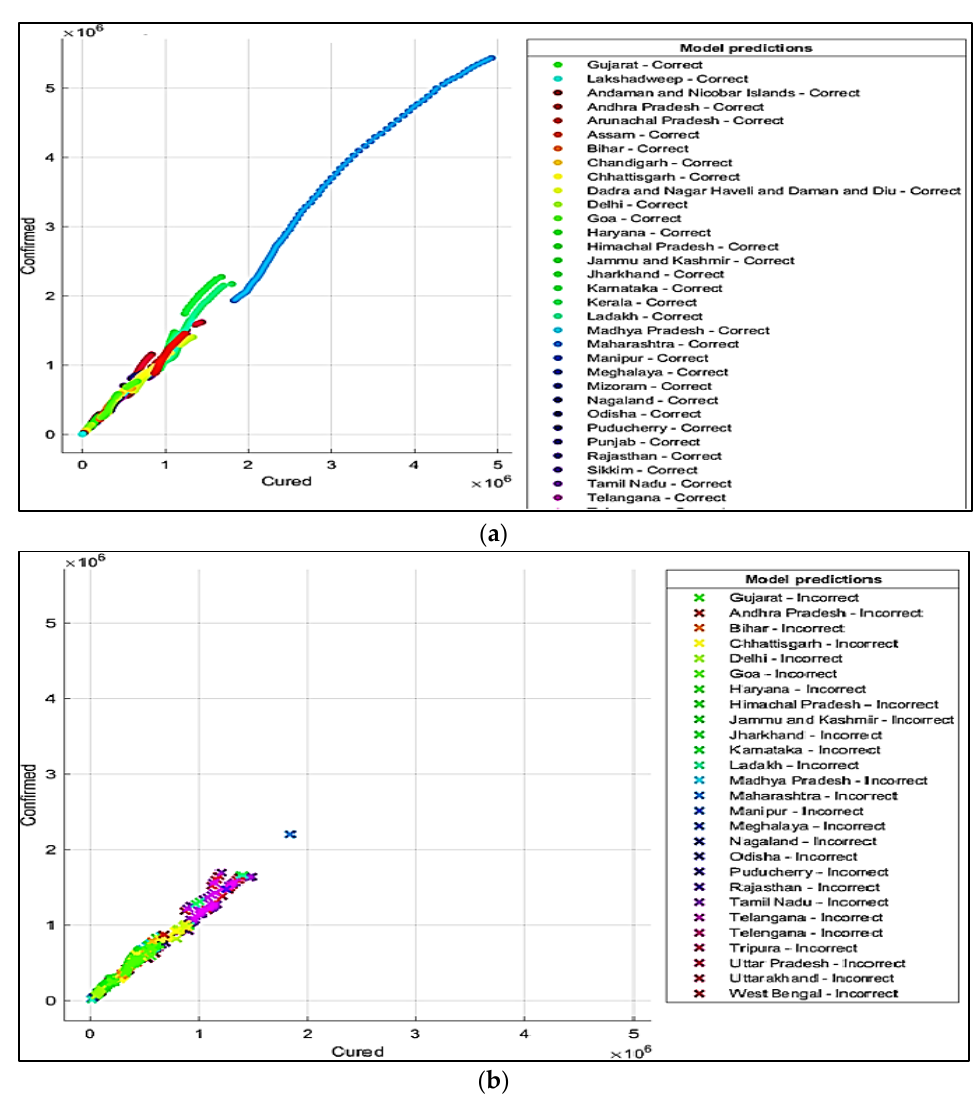
Figure 6. ( a ) Correct Predictions by SVM Model ‘Cured’ vs. ‘Deaths’. ( b ) Incorrect Predictions by SVM Model ‘Cured’ vs. ‘Deaths.